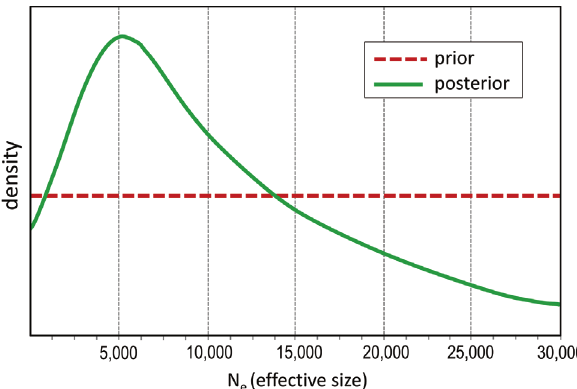
Figure 3 - Posterior distribution (in green) of the parameter N e from the best-supported scenario (Scenario 1, constant population, see Figure 2) as estimated in the program DIYABC. The red line is the prior distribution for N e